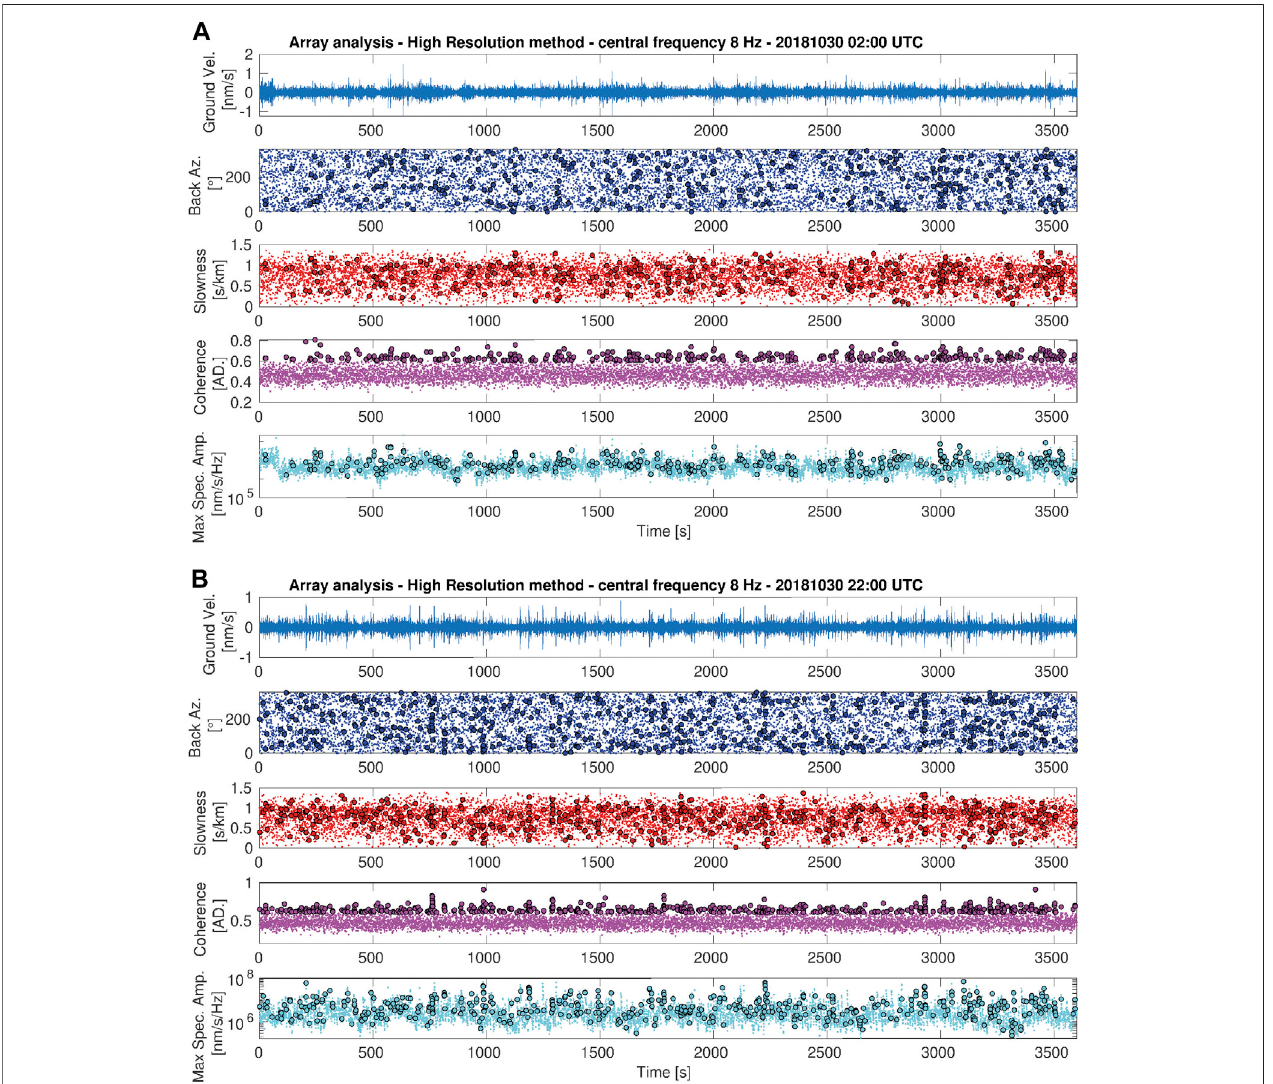
FIGURE 10 | High resolution array analysis for 1-h signal at 02:00 UTC (top) and 22:00 UTC (bottom) for 30 October 2018 at the SUBA stations (101, 102, 103, 138, 151 and 115 in Figure 1C ). Larger colored circles show back-azimuth, slowness and spectral amplitude values for coherence estimates larger than 0.6.